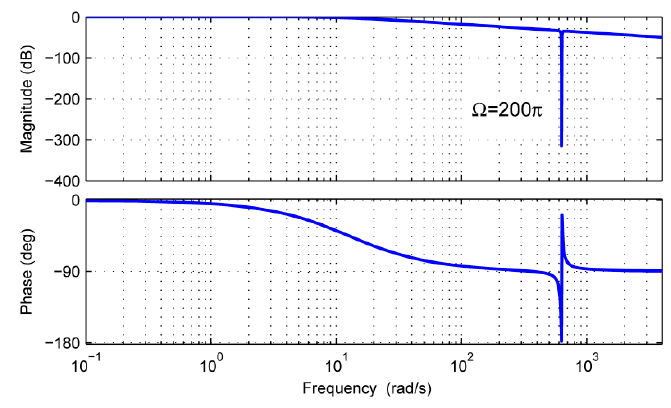
Figure 5. Frequency characteristics of G 3 (s).